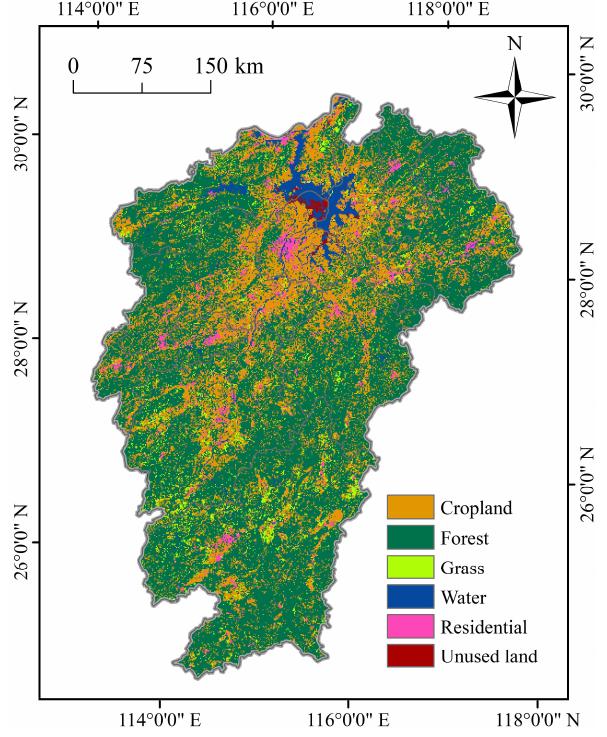
Figure 9. Land use map of the PLB.